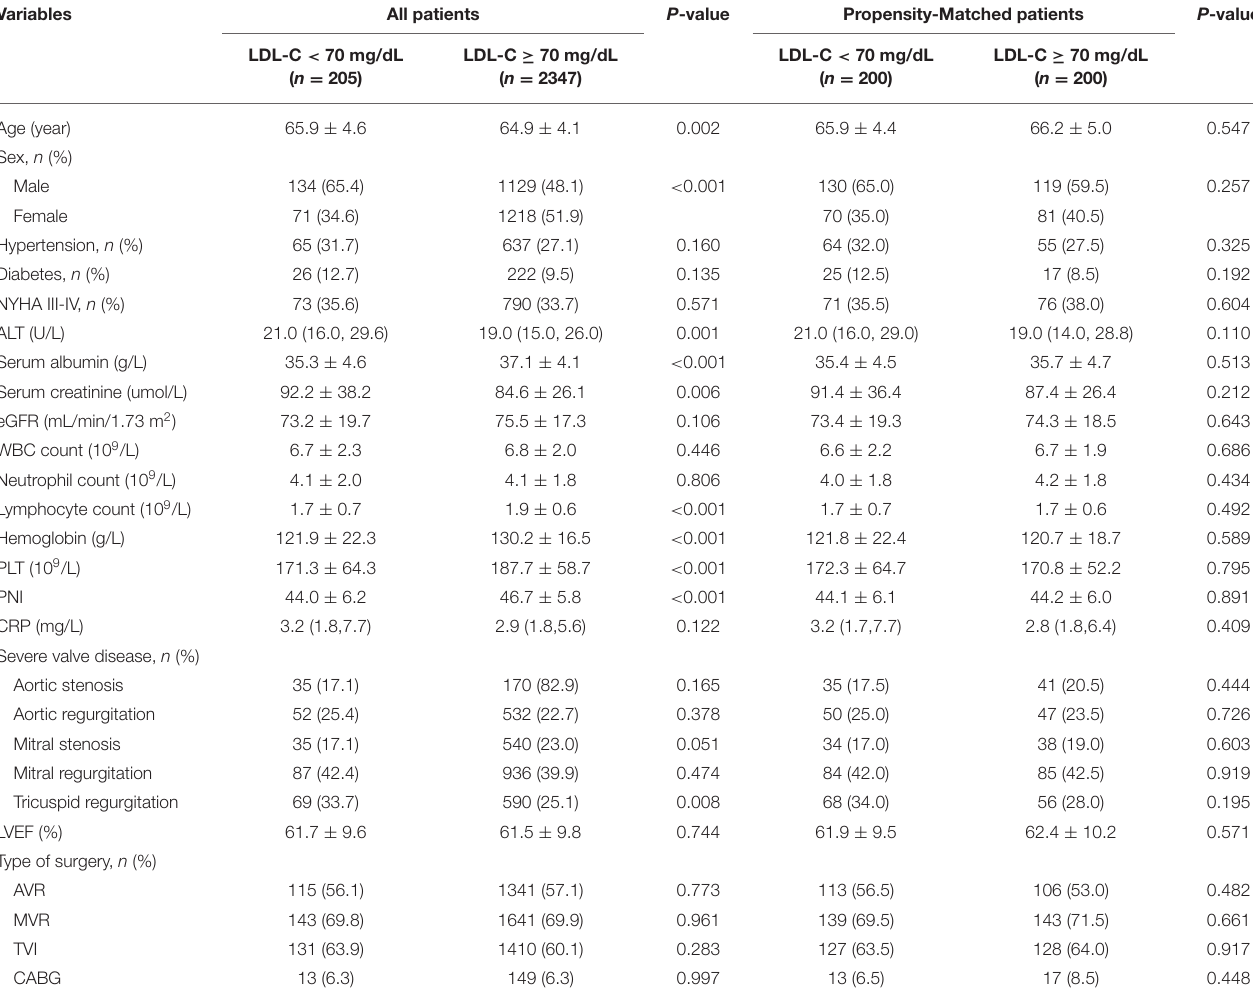
TABLE 1 | Baseline clinical characteristics.